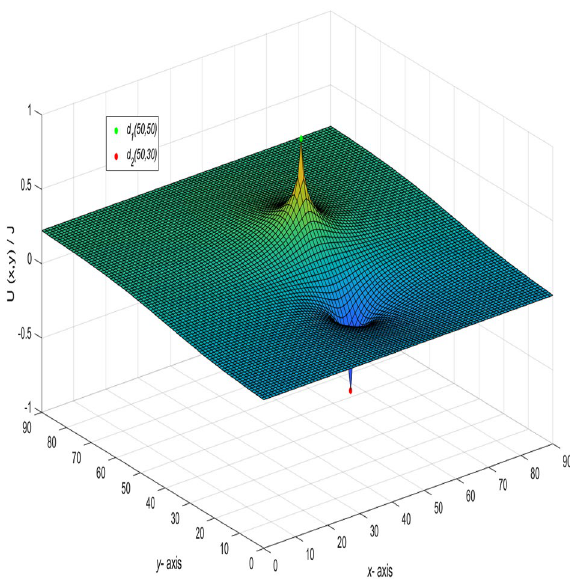
Figure 7. The process of forming a 3D dynamic view for U 90